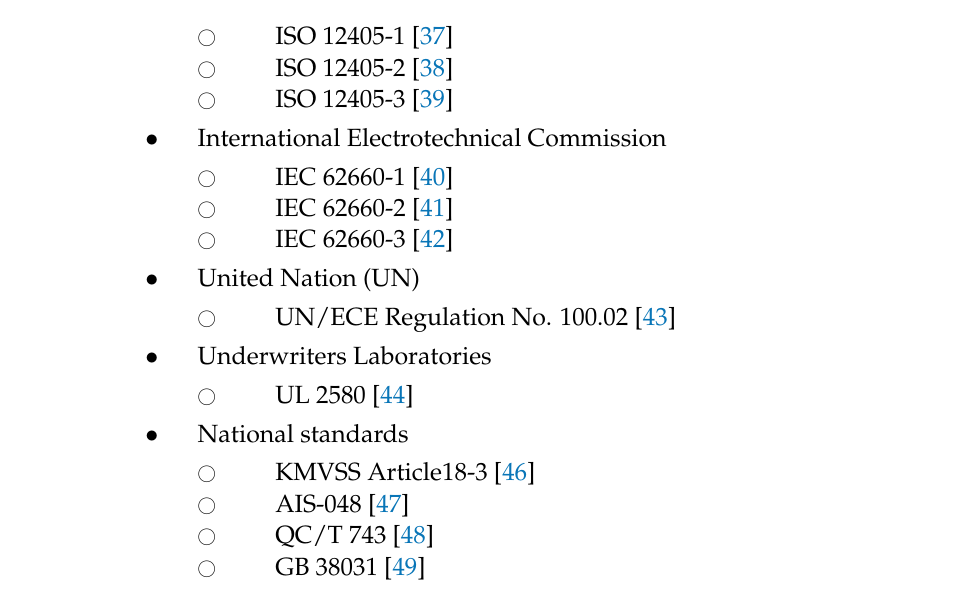
Table 1. List of international standards, regulations, and national standards and their levels of mechanical tests, (from Ruiz et al. [45], with permission from